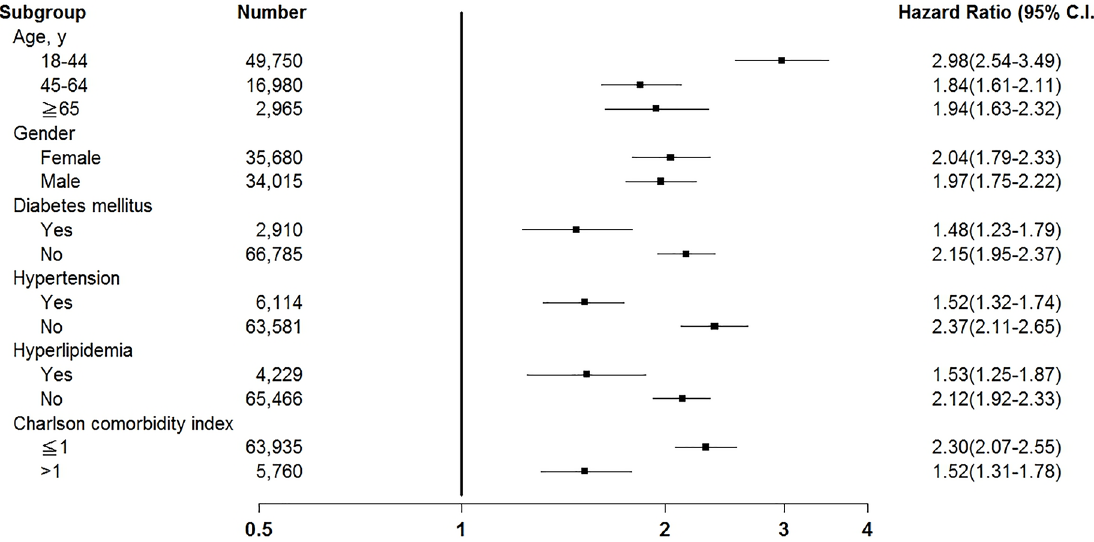
Fig 2. Subgroup analysis of risk of major adversecardiovascular events in patients with carbon monoxide poisoning and controls.